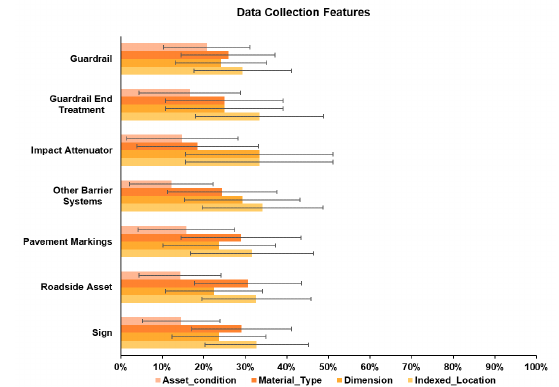
Figure 7 . Breakdown of state DOTs’ Data Collection Features for the different assets of the Roadside Asset Systems.